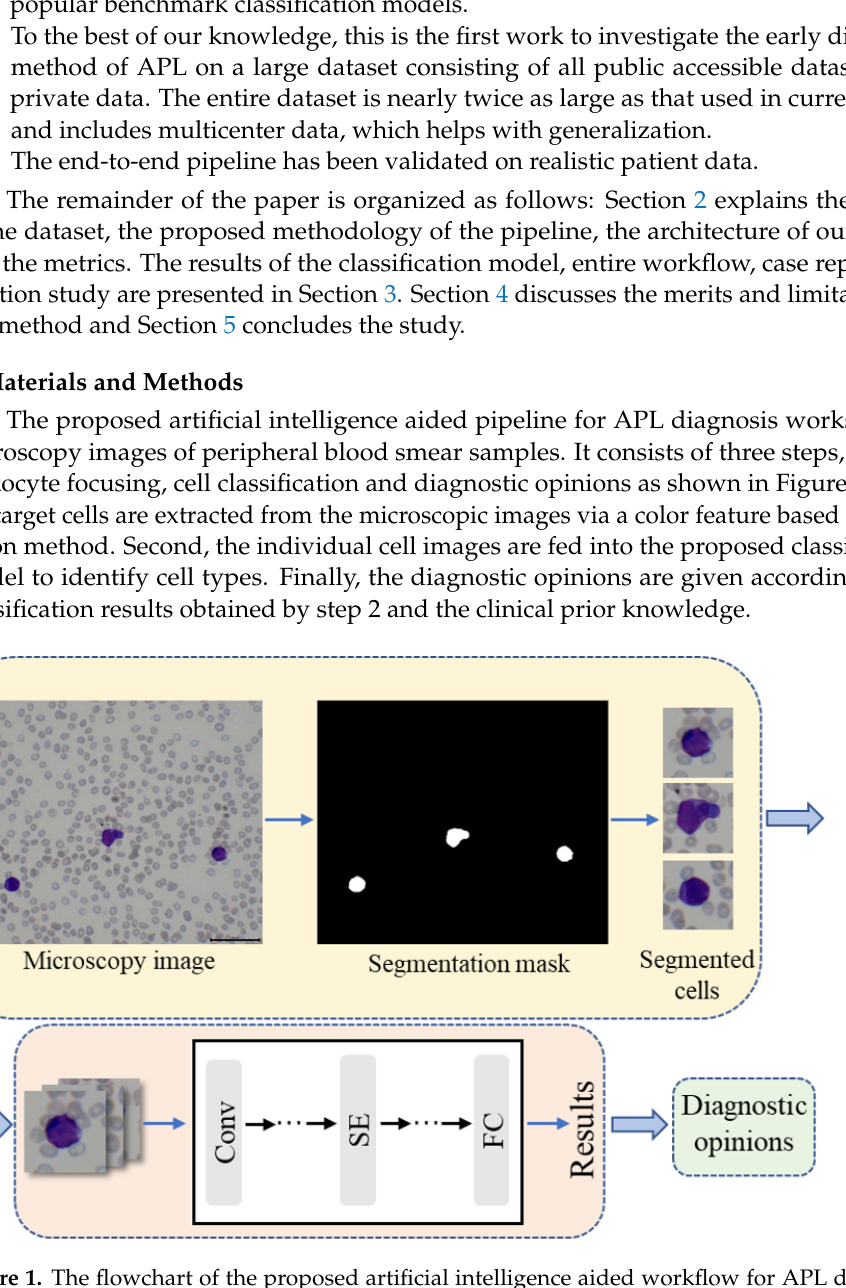
Figure 1. The flowchart of the proposed artificial intelligence aided workflow for APL diagnosis, which includes leukocyte focusing, cell classification and diagnostic opinions